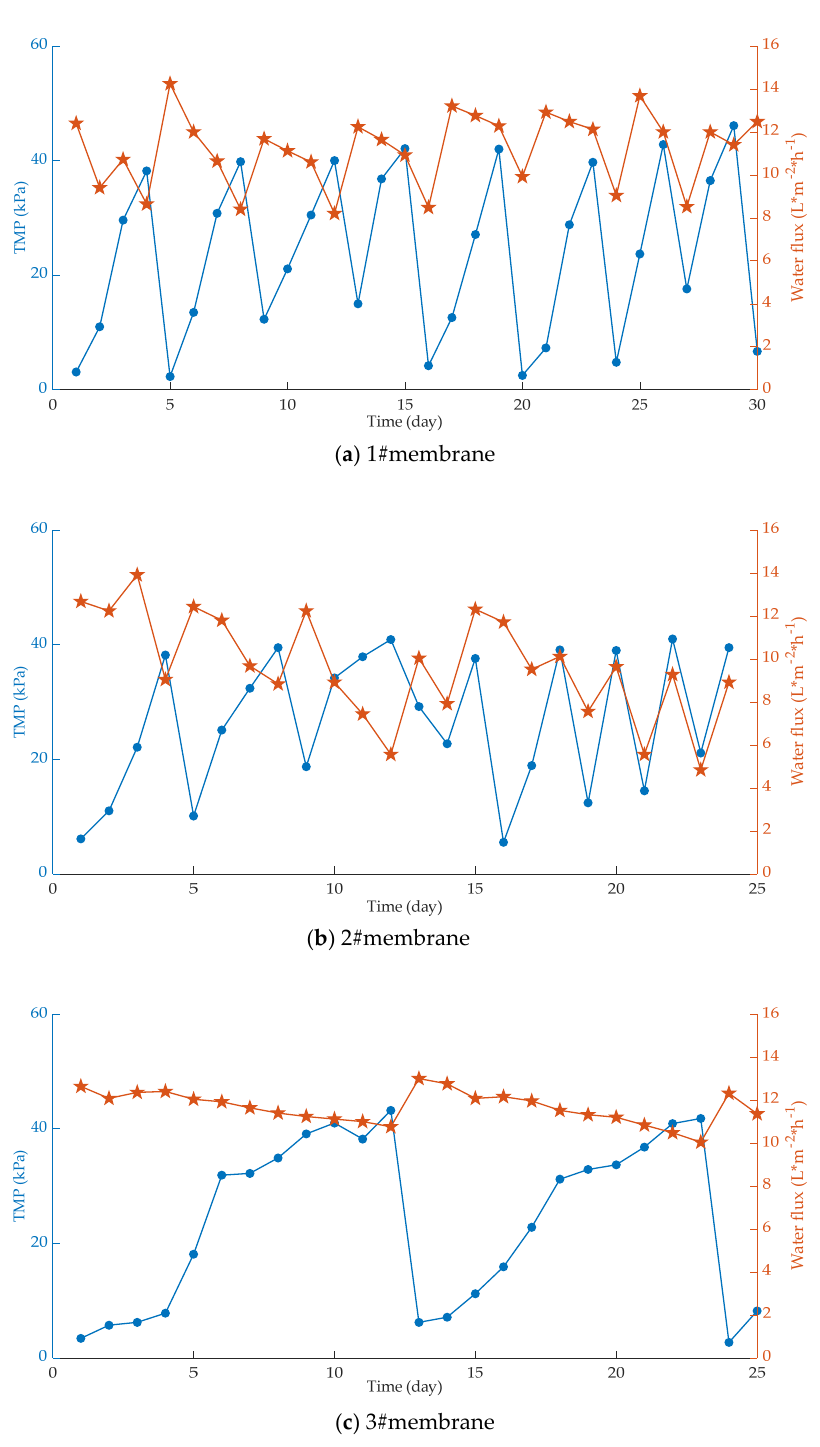
Figure 2. Temporal variations of flux and transmembrane pressure (TMP) when membranes with different pore sizes are used. ( a ) 1#membrane; ( b ) 2#membrane; ( c ) 3#membrane.